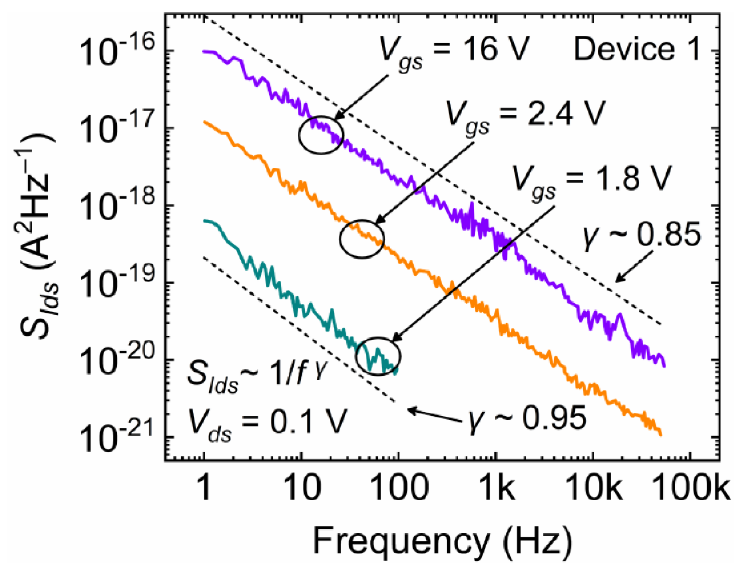
Figure 2. Relationship between the frequency and S Ids , measured at different gate voltages from the subthreshold region ( V gs = 1.8 V) to the above-threshold region ( V gs ≥ 2.4 V). The value of γ in the subthreshold and above-threshold regions are approximately 0.95 and 0.85, respectively.